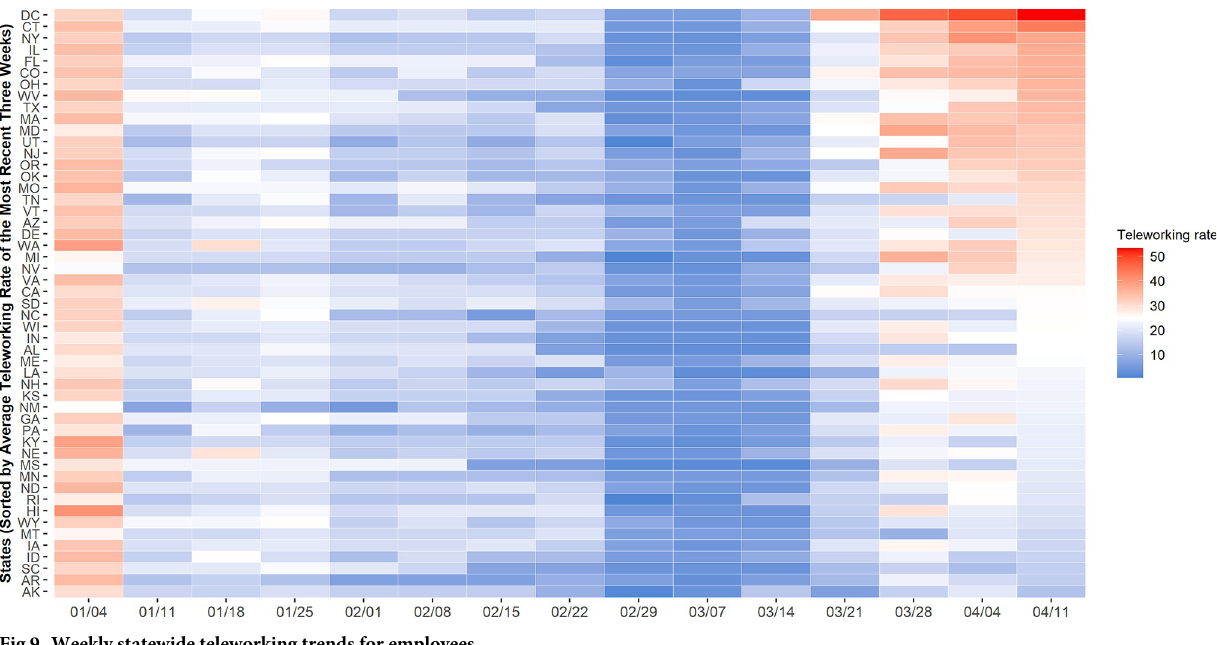
Fig 9. Weekly statewide teleworking trends for